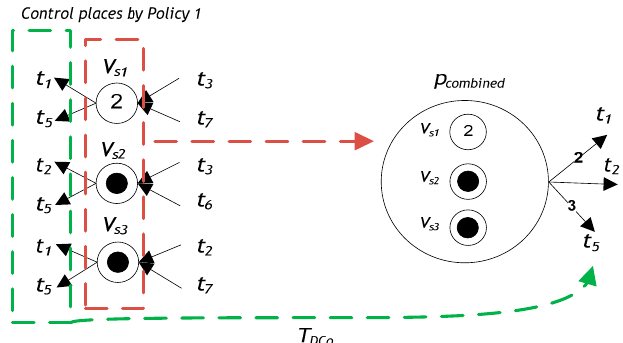
Figure 4. Output arcs of p combined for all monitors P V .